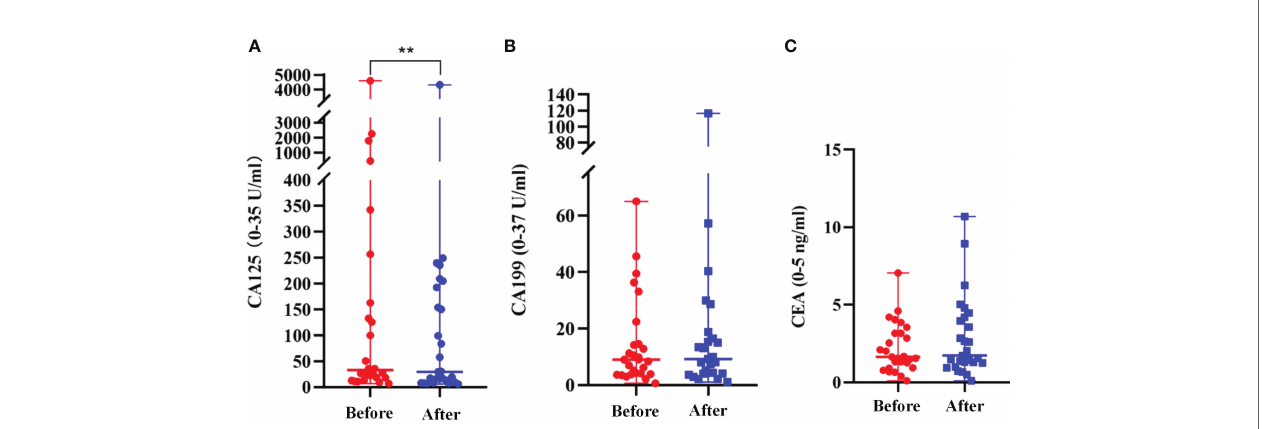
DMPM, diffuse malignant peritoneal mesothelioma; CR, complete response; PR, partial response; SD, stable disease; PD, progressive disease; ORR, objective response rate; DCR, disease control rate; No.,